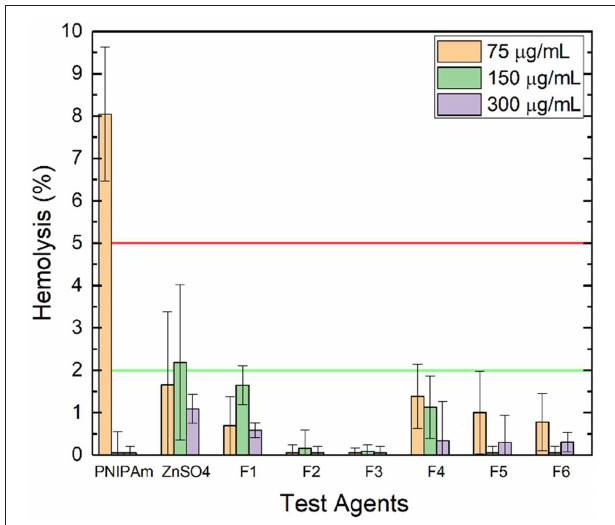
FIGURE 8 | Hemolysis percentage at 75, 150, and 300 µ